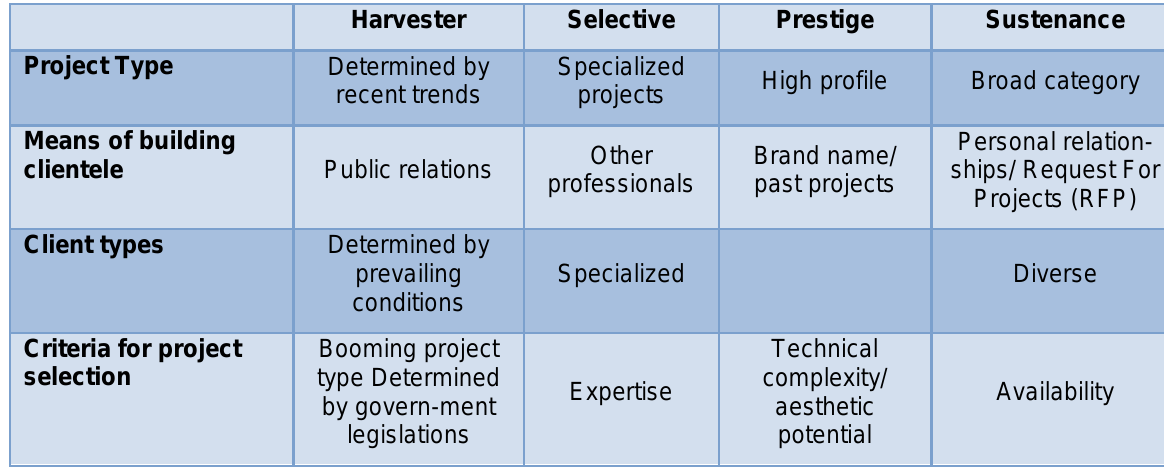
Table 1 Characteristics of strategy types derived by Katsanis and Katsanis (2001) Source: Adapted from Katsanis and Katsanis